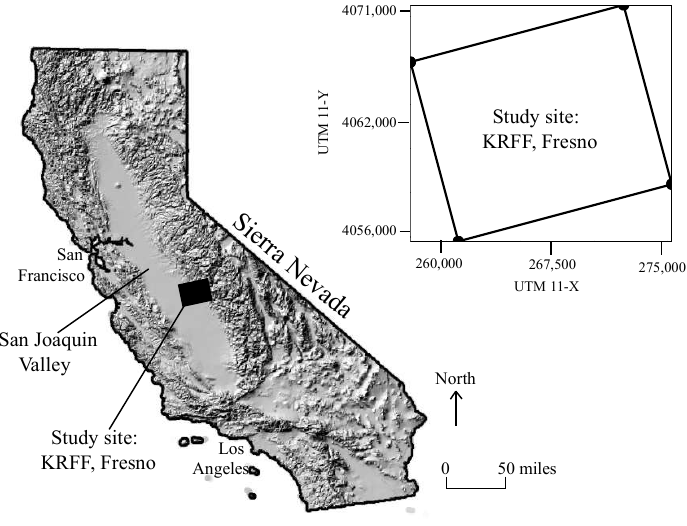
Figure 1. The study area location of KRFF, Fresno, California.